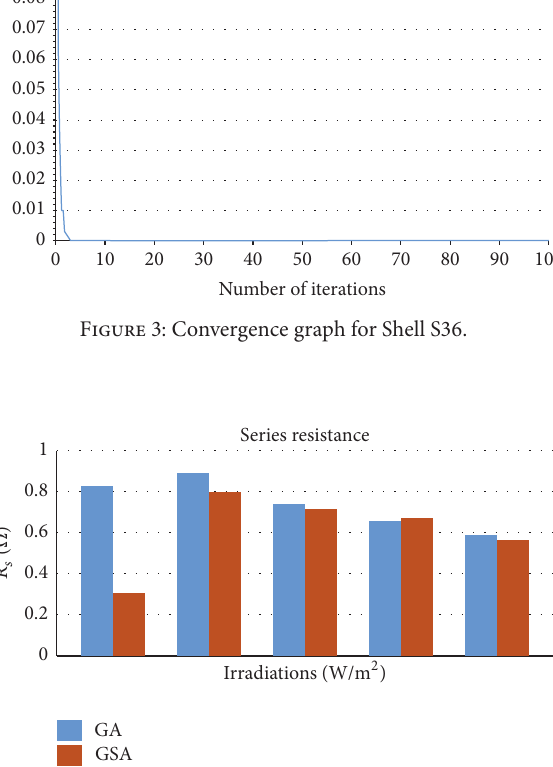
Figure 6: Comparison of the optimized ideality factor values of Shell S36 under different irradiance conditions.